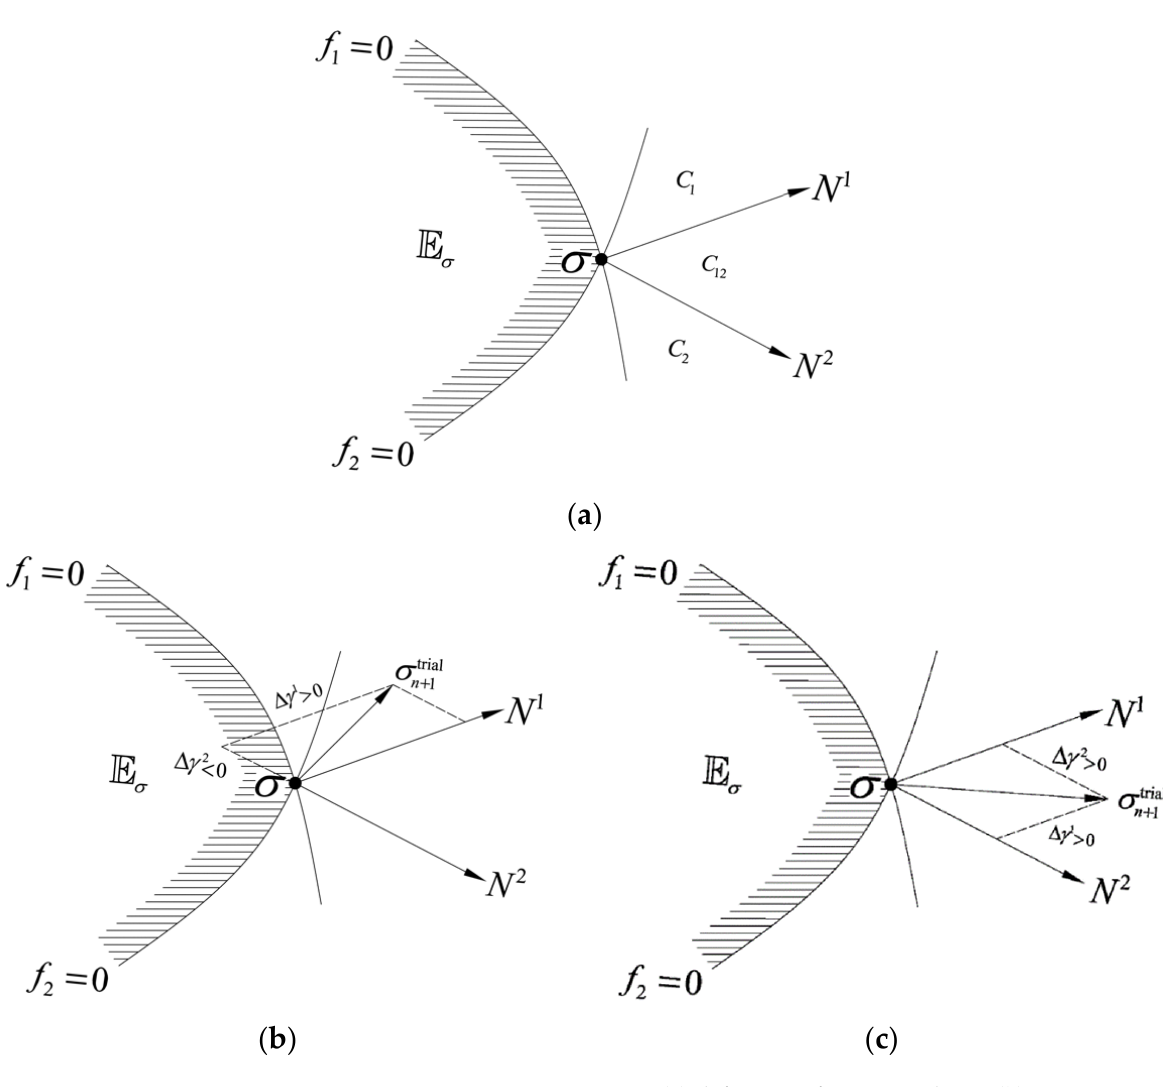
Figure 2. Geometry at a corner point. ( a ) definition of C 1 , C 2 and C 12 ; ( b ) region C 1 : ∆ γ 1 > 0, ∆ γ 2 < 0; ( c ) region C ∆ γ 1 > 0, ∆ γ 2 > 12 :